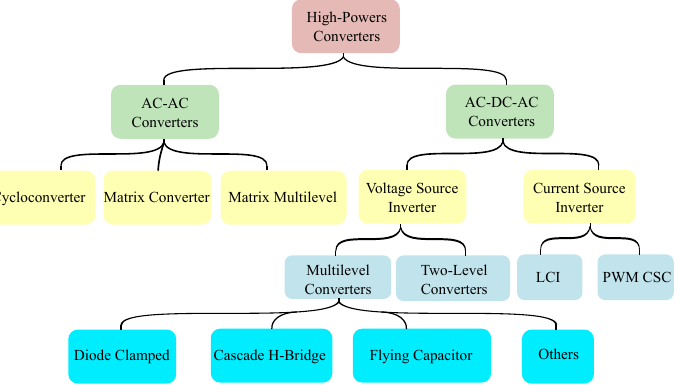
Figure 1. Classification of high-power